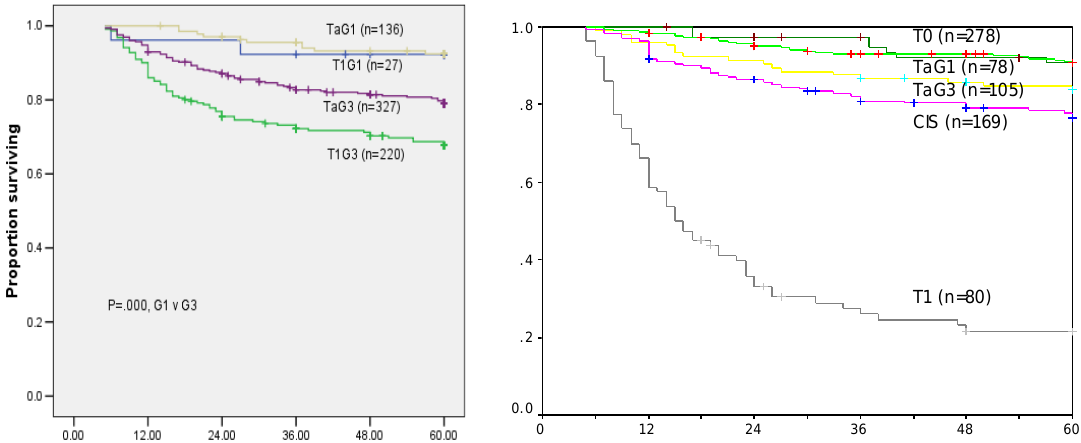
FIGURE 1. Progression-free survival of 710 NMIBC patients, according to stage and grade, after first (left) or second (right) TUR.